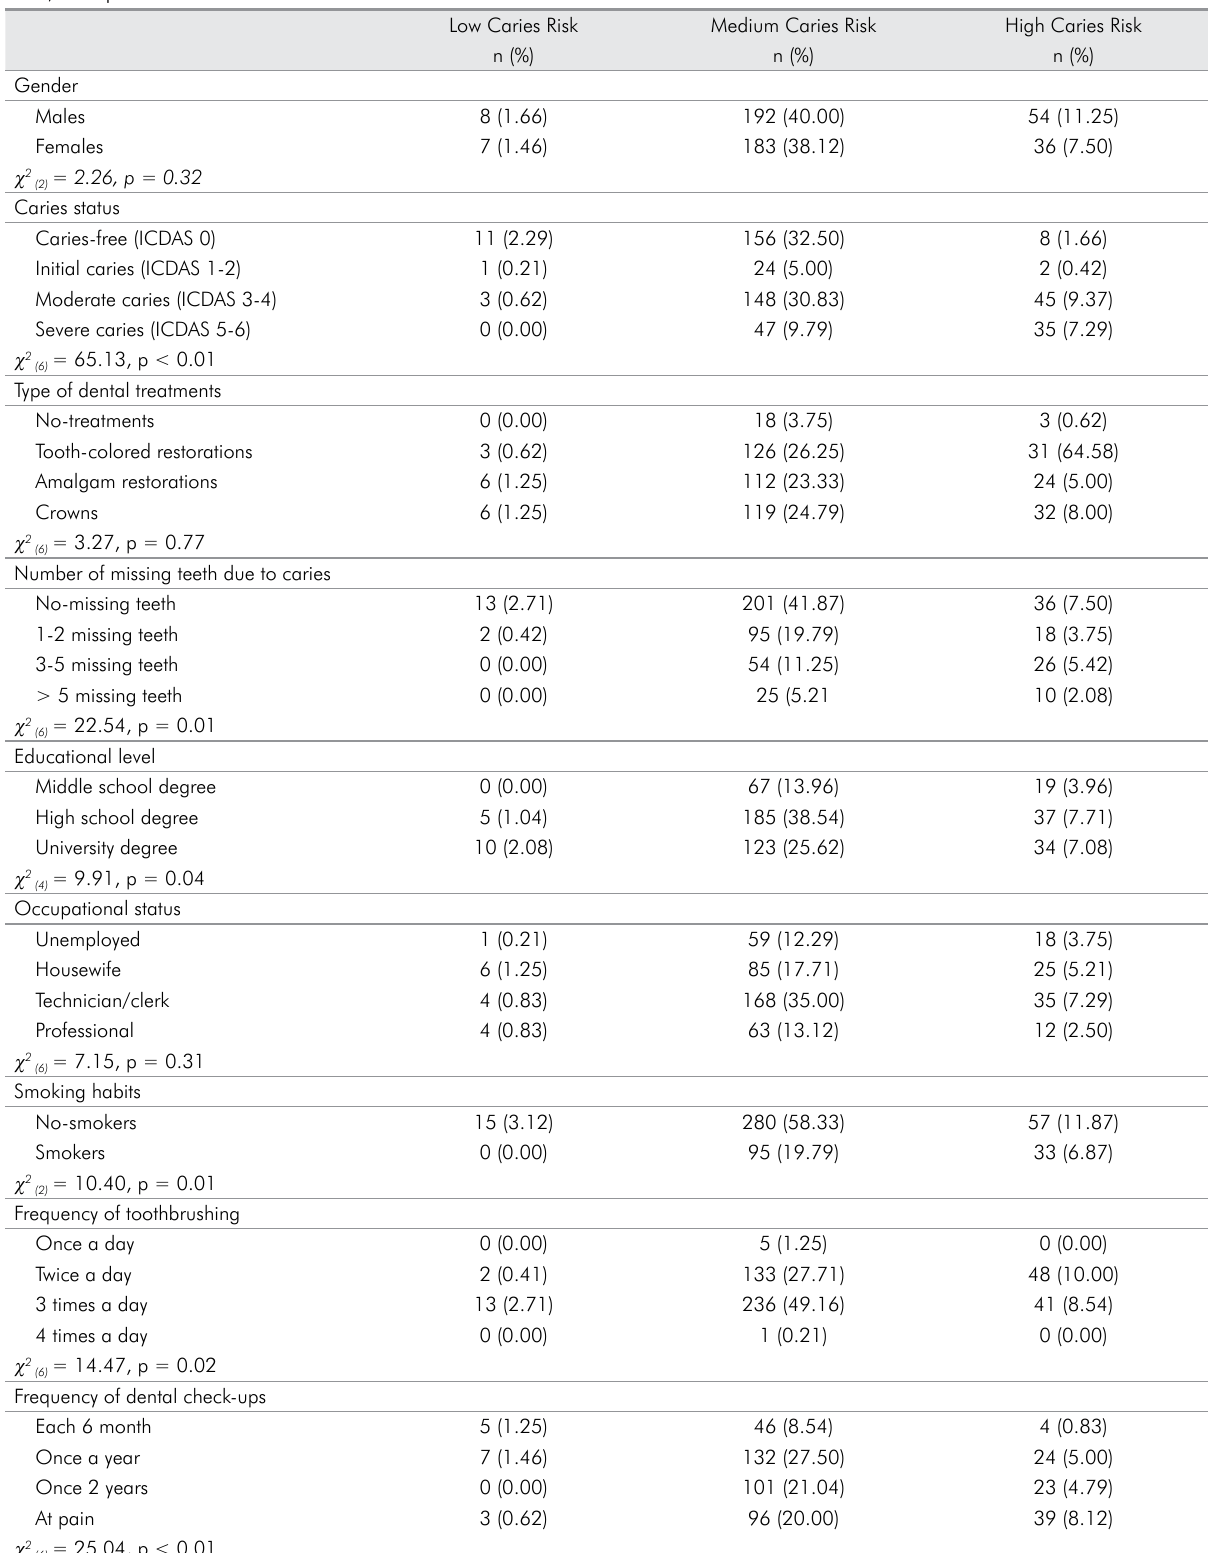
Table 2. Sample distribution by caries risk level (low, medium or high) according to gender, caries status, and treatment educational level, occupational status and behavioural